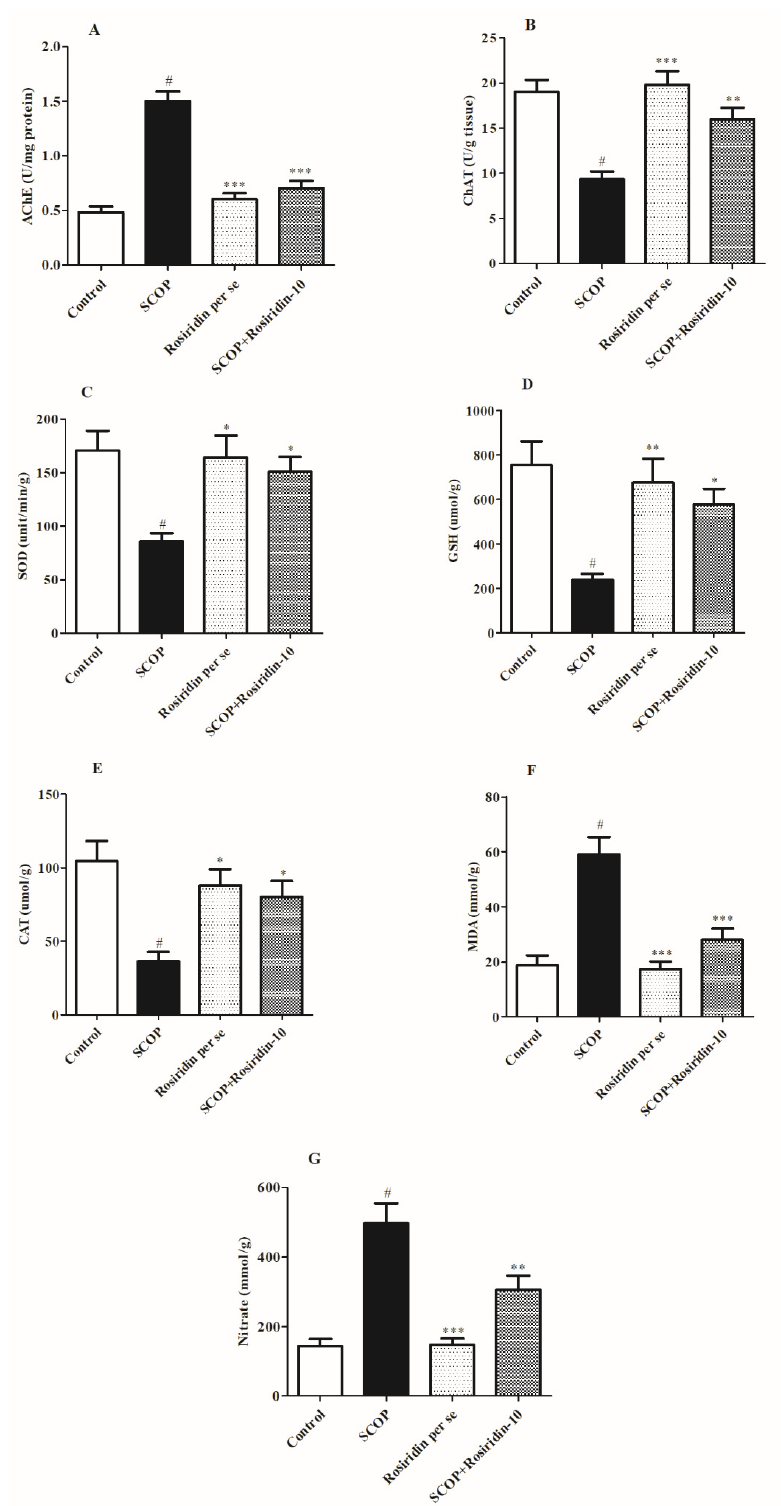
Figure 6. Graphs illustrating the effect of rosiridin on ( A ) AChE, ( B ) ChAT, ( C ) SOD, ( D ) GSH, ( E ) CAT, ( F ) MDA, and ( G ) nitrite level estimation. Mean ± S.E.M. ( n = 6). # p < 0.001 vs. normal control, *** p < 0.001 vs. scopolamine control, ** p < 0.01 vs. scopolamine control, * p < 0.05 vs. scopolamine control; one-way ANOVA followed by Tukey’s